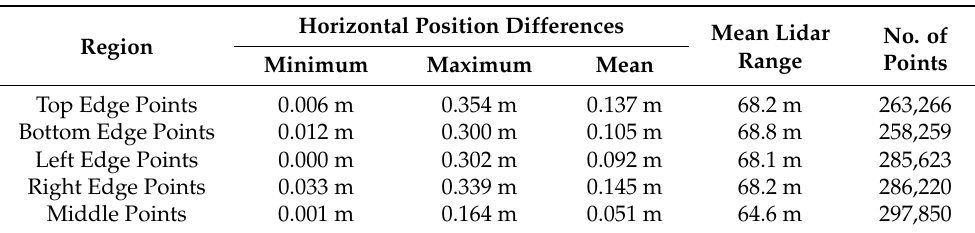
Table 7. Quantitative measures for the horizontal position differences of points within the five regions of interest for flight A.